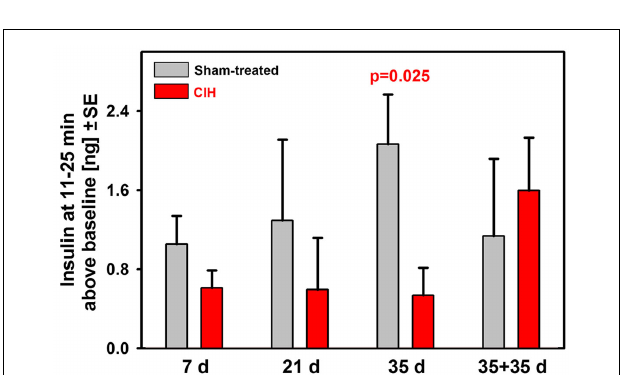
FIGURE 3 |Average time-course of glucose-stimulated insulin release during the ivgtt conducted following 7, 21, 35days of exposure to CIH or sham treatment and in rats subjected to CIH/sham treatment for 35days and then normally housed for another 35days. While there were only minor differences in the baseline insulin levels between the CIH and sham-treated rats, the differences between insulin levels during the second phase of insulin release (11–25min after glucose bolus) were large and increased with the duration of CIH exposure (A–C) .This was due to a